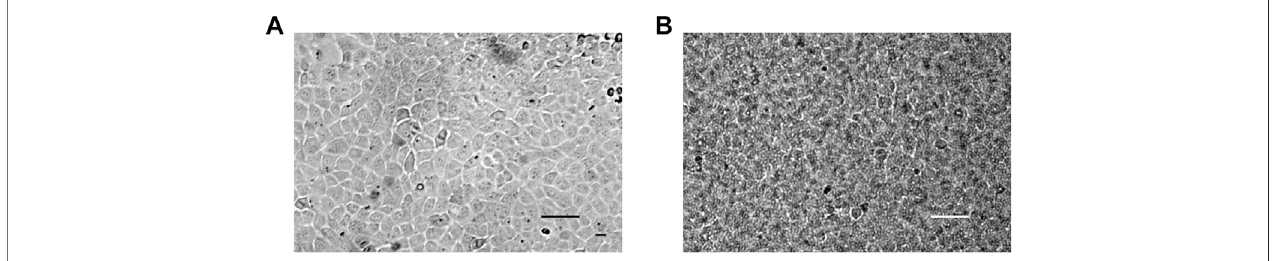
FIGURE 1 | Morphology of 2D HAT-7 cell cultures. (A) HAT-7 cells grown in control medium as a conventional monolayer on plastic in a T-25 culture fl ask for 3 days. (B) HAT-7 cells grown in differentiation medium as a polarized monolayer on a Transwell permeable support for 7 days. Also visible are the 0.4 µm pores in the polyester supporting membrane. Scale bars: 100